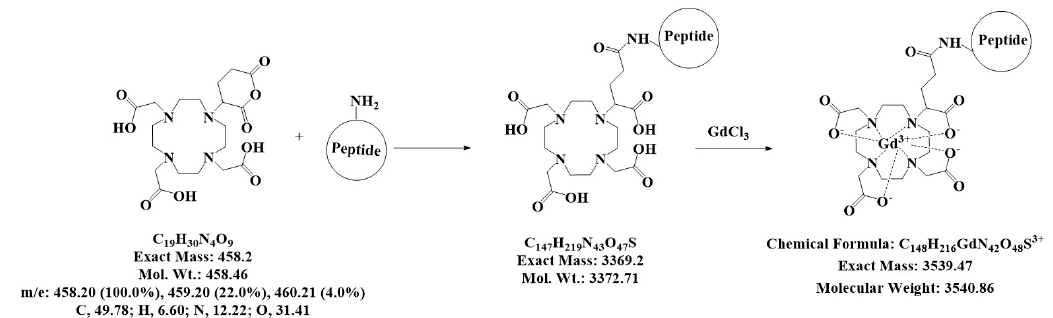
Figure 1. Coupling of the peptides to DOTA. Scheme for the synthesis of the two contrast agents (CA), namely Gd-DOTA-P88 and Gd-DOTA-Scramble, which were produced by coupling P88 or Scramble to DOTA, and thereafter complexing it with GdCl 3 to prepare the CA for MRI. The characteristics of the chemical structures are outlined beneath the reaction.